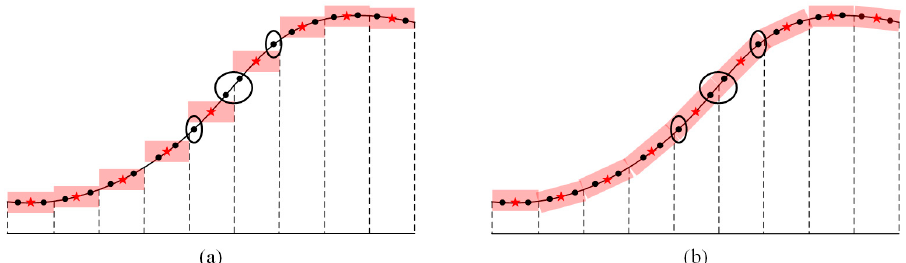
Figure 5. Ground point extraction based on the terrain consists of ( a ) horizontal and ( b ) locally fitted planes. The ground points on the steep slope can be correctly recognized based on the locally fitted planes, as shown in the ellipses. Red pentagrams, black points and red rectangles represent ground seeds, ground points and terrain buffers for extracting ground points, respectively.